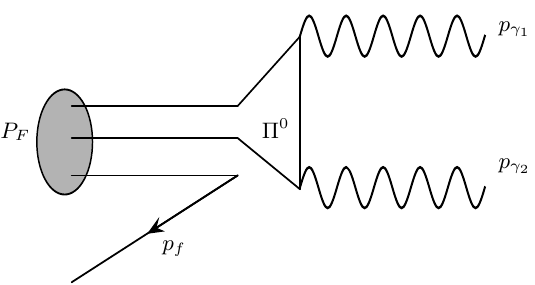
Figure 5 . We show the diagram of a composite fermion (three parallel solid lines) decaying to an SM elementary quark or lepton (the solid line with an arrow) and a composite boson, the latter decays into two SM gauge bosons (wave lines), see figure 4. The composite boson Π 0 is an intermediate state. p f represents the energy momentum of quark or lepton. p γ the energy momentum of two photons or two gauge bosons G and G ′ . The composite fermion is heavier than composite boson Π 0 , M F > M Π 0 , and the energy-momentum of composite fermion E F = M F at its rest frame ( P F = 0), as described in eq.